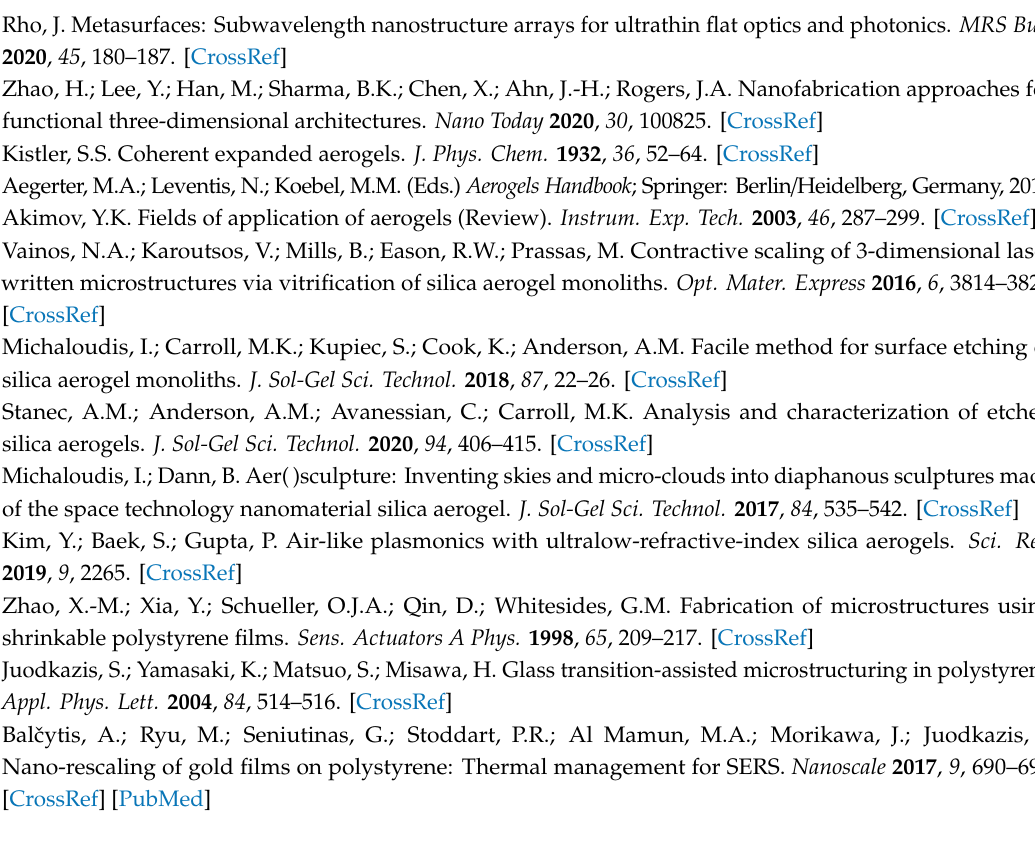
Figure S1: Dimensional reduction vs. process temperature, Figure S2: Au droplet formation. Figure S3: Silicon CGH master and optical